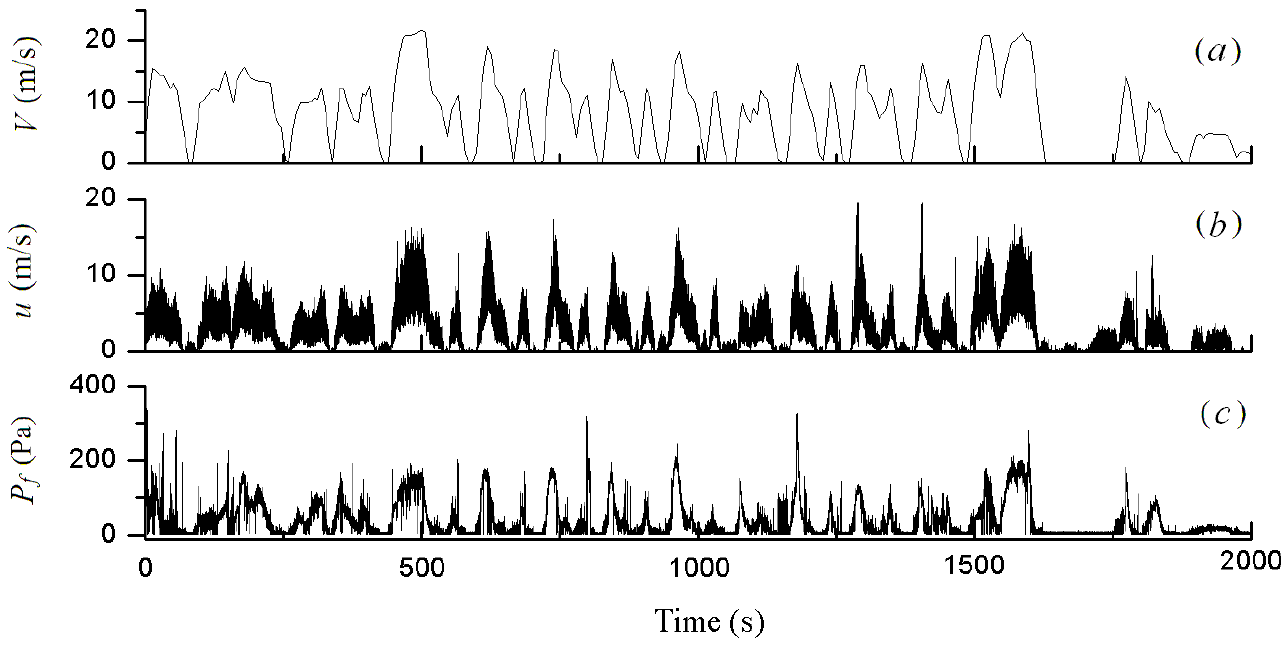
Figure 3. Time histories of measured data: ( a ) train speed ( V ), ( b ) the longitudinal velocity ( u ) measured by the hotwire mounted on the first carriage, ( c ) the forward stagnation pressure ( P f ).